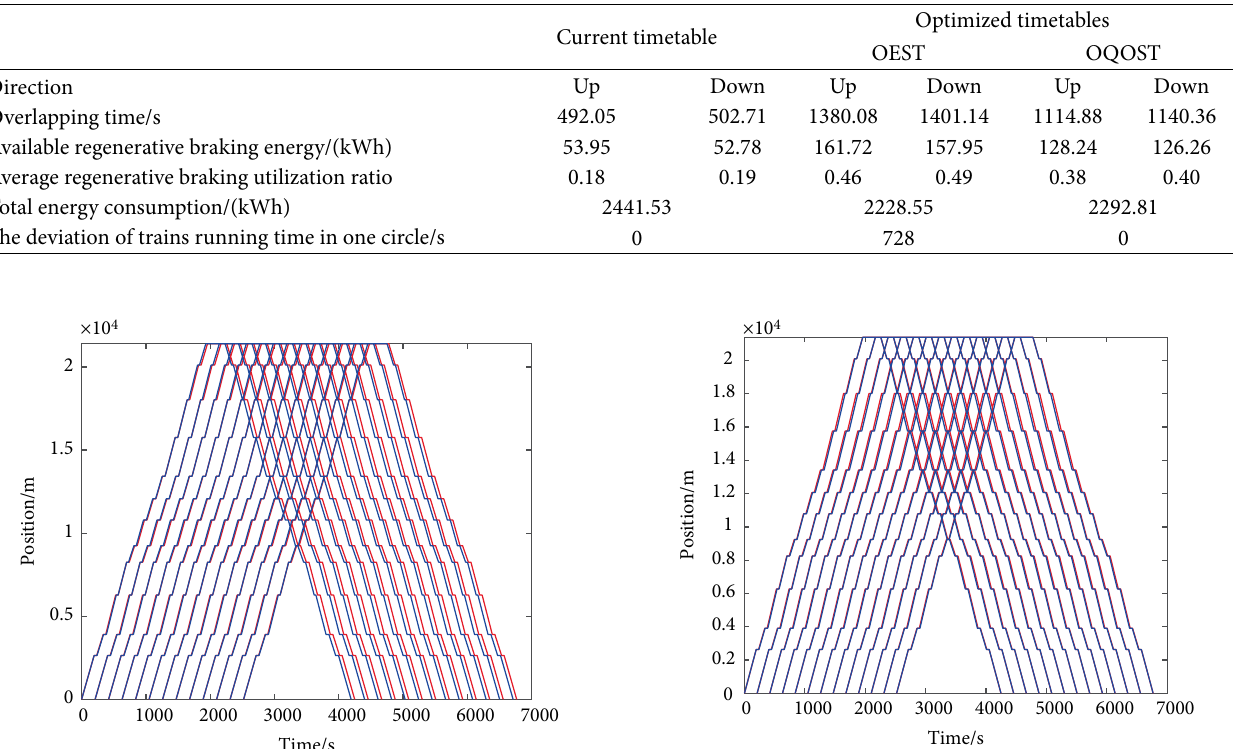
Figure 12: The regenerative braking energy utilization ratio in each section of the OQOST. Table 10: Comparison of energy saving and quality of service between the current timetable and optimized timetables.